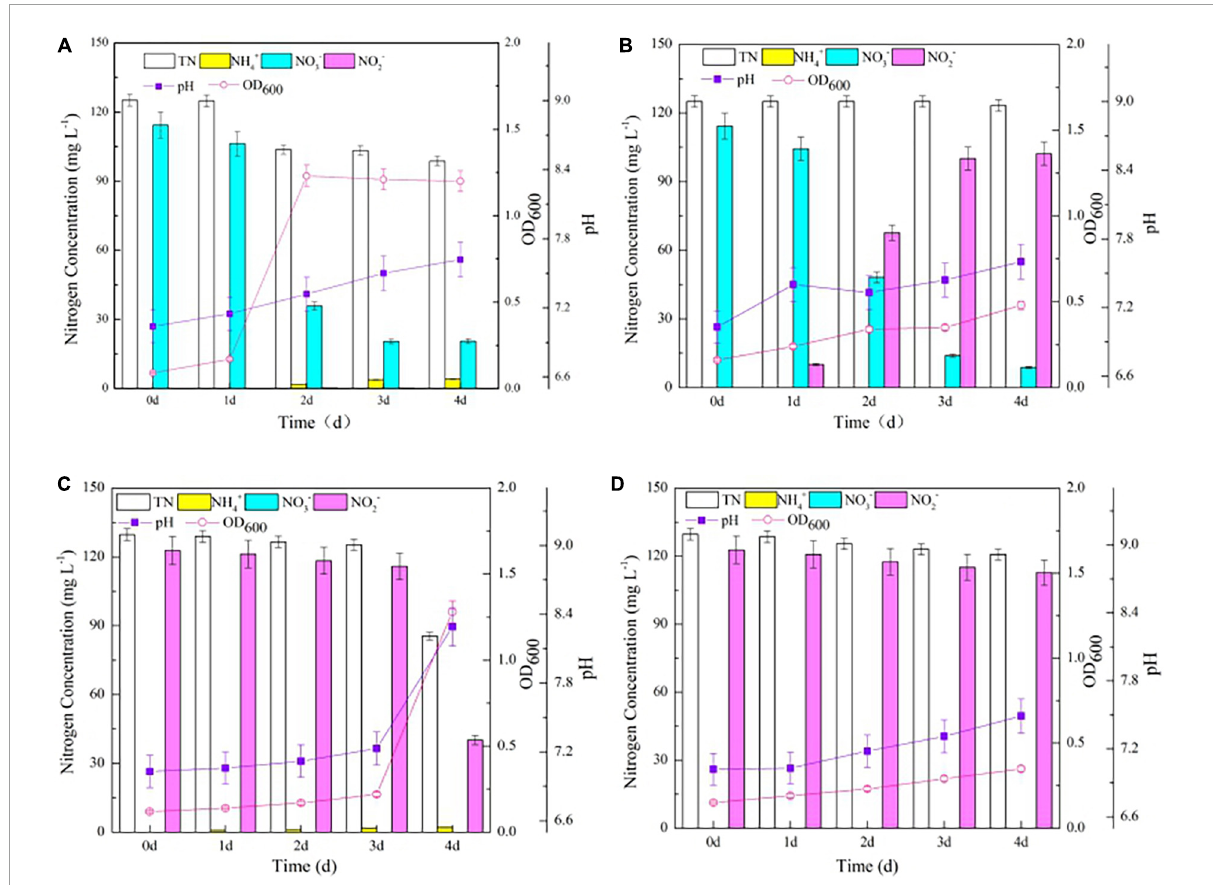
FIGURE4 The growth curve and nitrogen transformation performance of strain Y-9 in denitrification medium at 15 ◦ C. (A) The wild-type strain Y-9 in DM-1. (B) The (cid:77) nirBD strain Y-9 in DM-1. (C) The wild-type strain Y-9 in DM-2. (D) The (cid:77) nirBD strain Y-9 in DM-2.